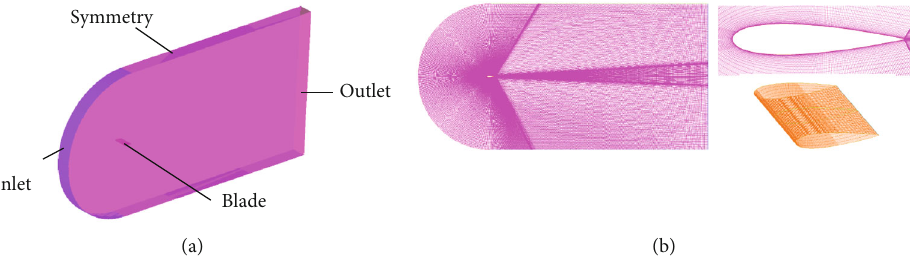
Figure 14: Mesh generation of NACA0018: (a) calculated three-dimensional domain and (b) mesh.